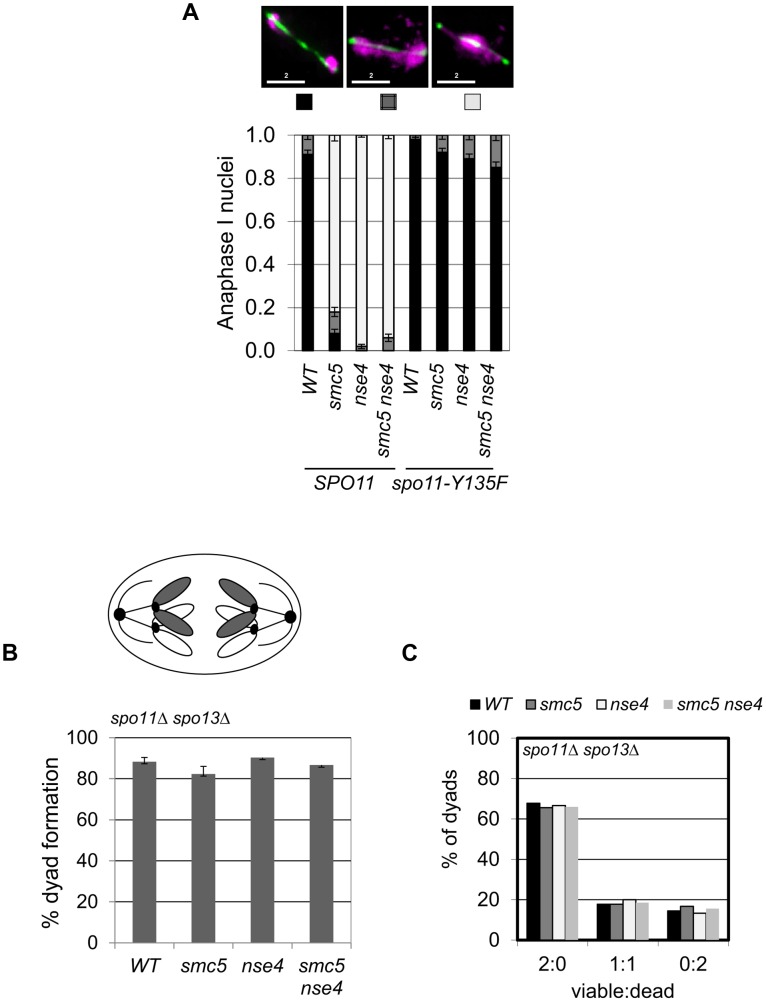
Meiotic depletion of Smc5 and Nse4 leads to Spo11-dependent nuclear separation defects in meiosis.(A) Catalytic-dead Spo11 mutation rescues nuclear separation at anaphase I in the Smc5/6 mutants (n≥100). Bars indicate standard error bars for a proportion. Strains: WT (Y1381), smc5 (Y2705), nse4 (Y2704), smc5 nse4 (Y3185), spo11-Y135F (Y3147), spo11-Y135F smc5 (Y3150), spo11-Y135F nse4 (Y3153), spo11-Y135F smc5 nse4 (Y4202). (B and C) Schematic of sister chromatid segregation at meiosis I in spo11Δ spo13Δ mutants. Dyad formation and viability after 24 hours in sporulation medium of Smc5/6 mutants in conjunction with the spo11Δ spo13Δ bypass. Strains: spo11Δ spo13Δ (Y2816), spo11Δ spo13Δ smc5 (Y2846), and spo11Δ spo13Δ nse4 (Y2848).